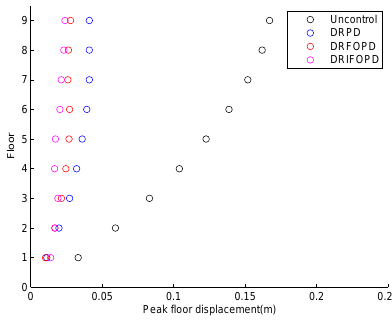
Figure 9. Maximum displacement of each floor under decentralized control.